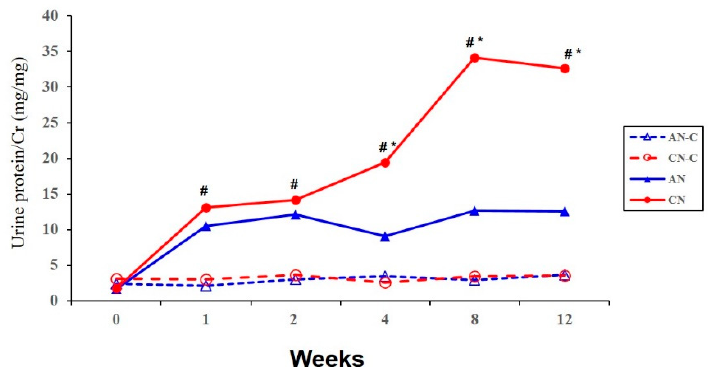
Figure 3. The 24-h urine protein-to-creatinine ratio in experimental glomerulonephritis rat groups. There was a marked increase in proteinuria in the CN groups compared to the AN groups from Week 4 to 12. * p < 0.05 vs. AN; # p < 0.05 vs. AN-C/CN-C. AN, acute nephritis; AN-C, control group for acute nephritis; CN, chronic nephritis; CN-C, control group for chronic nephritis.